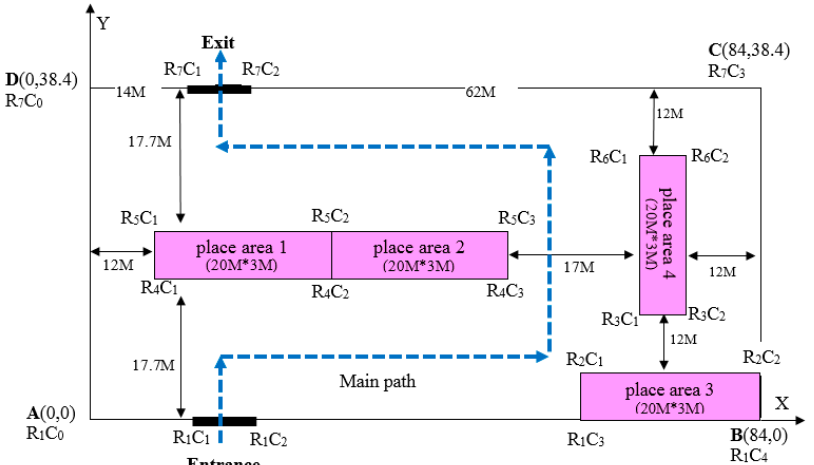
Figure 7. The layout template of the main structure of grounded objects in the galley (7th building in the Taipei Railway Workshop (TRW) and the size is 84 × 38.4 m in Length × Width). Table 7. The coordinates on the vertexes of edges in the layout template.